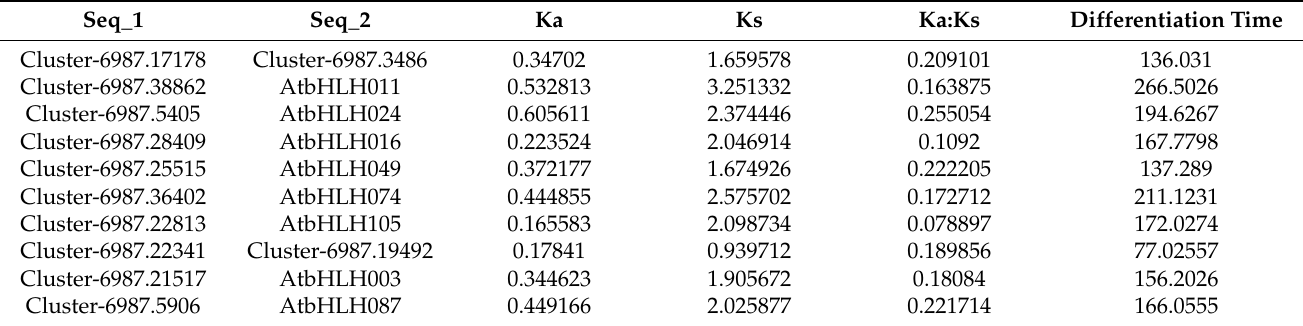
Table 2. Ka, Ks, and Ka:Ks values between homologous bHLH gene pairs.